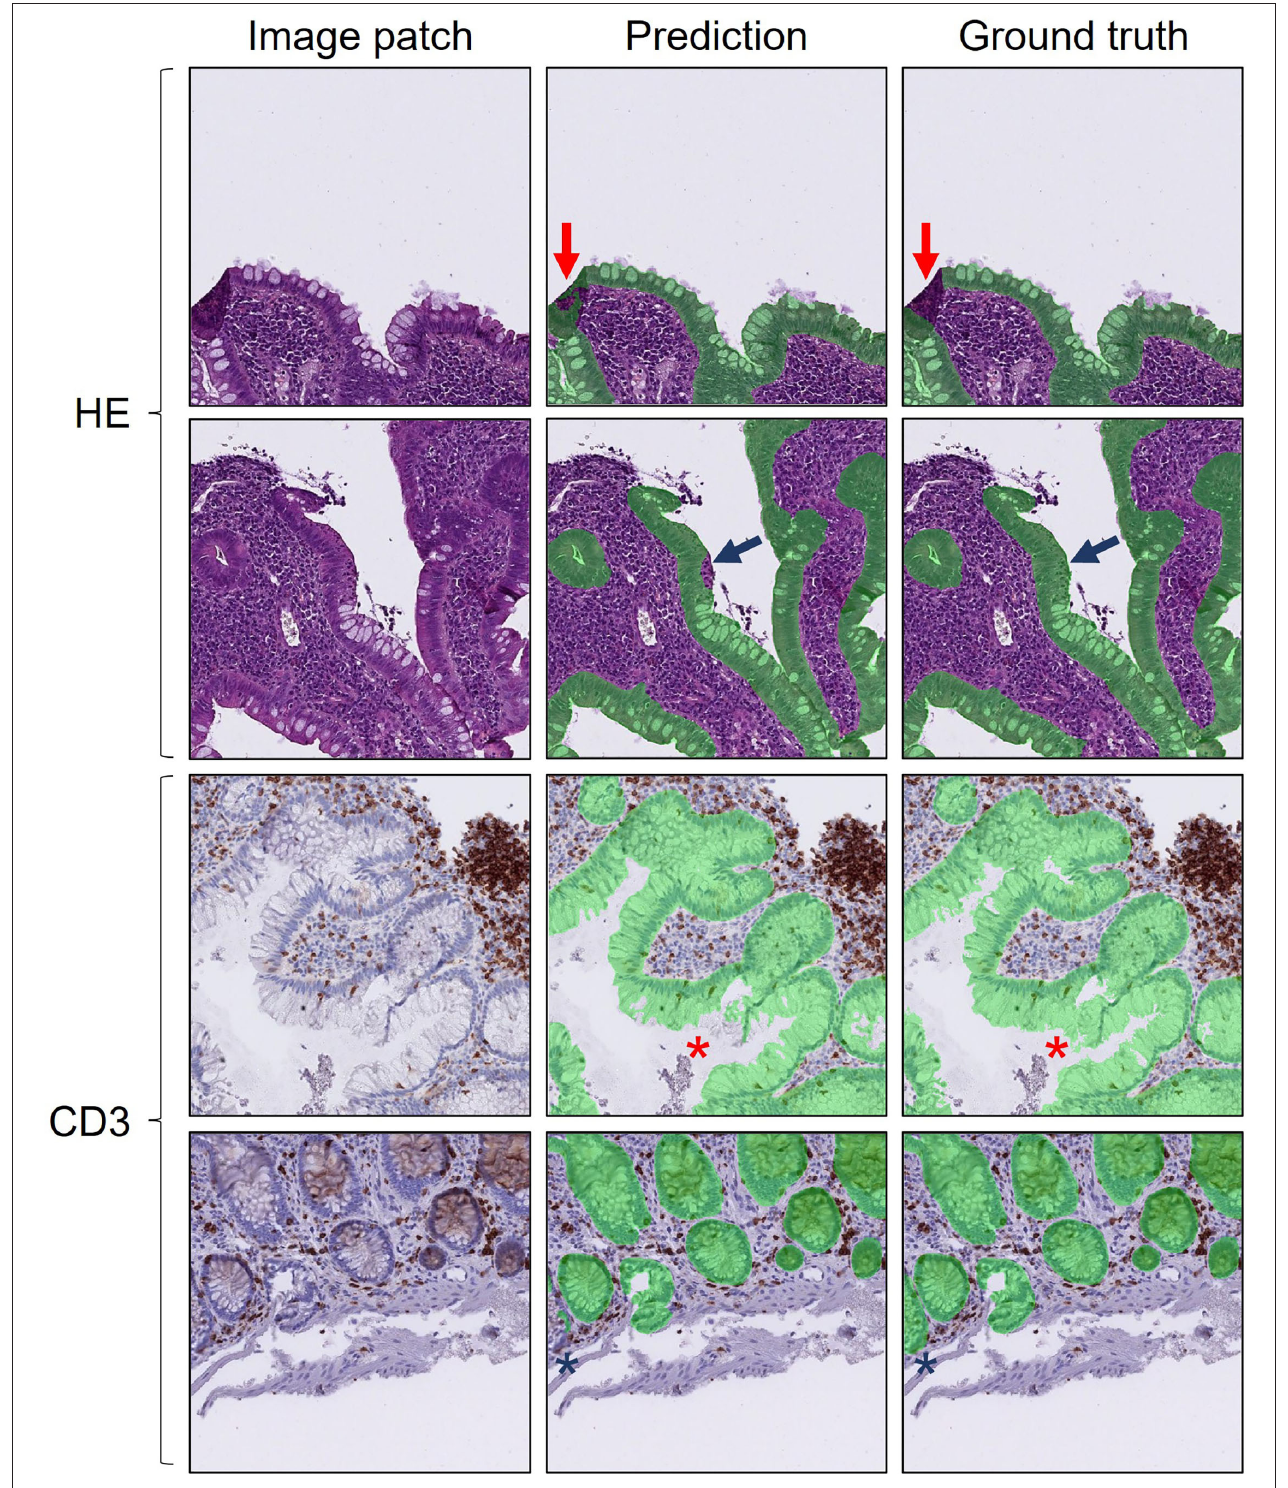
FIGURE 3 | Examples of prediction errors in difficult regions: HE stained images with folding artifacts (top row, red arrows) and granulocyte aggregates (second row, blue arrows). CD3 immunostained images with thick mucin rich epithelium (third row, red stars) and poorly fixated blurred epithelium at the edge of a patch (bottom row, blue stars). Prediction (middle column) and ground truth (right column) of epithelial segmentation are shown in transparent green. 512 × 512-pixel image patches displayed in DeepMIB.